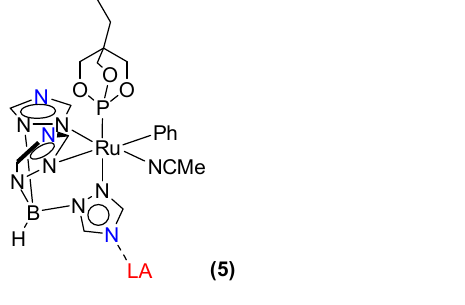
Figure 4. The possible interaction between triazole ring and Lewis acid (LA).